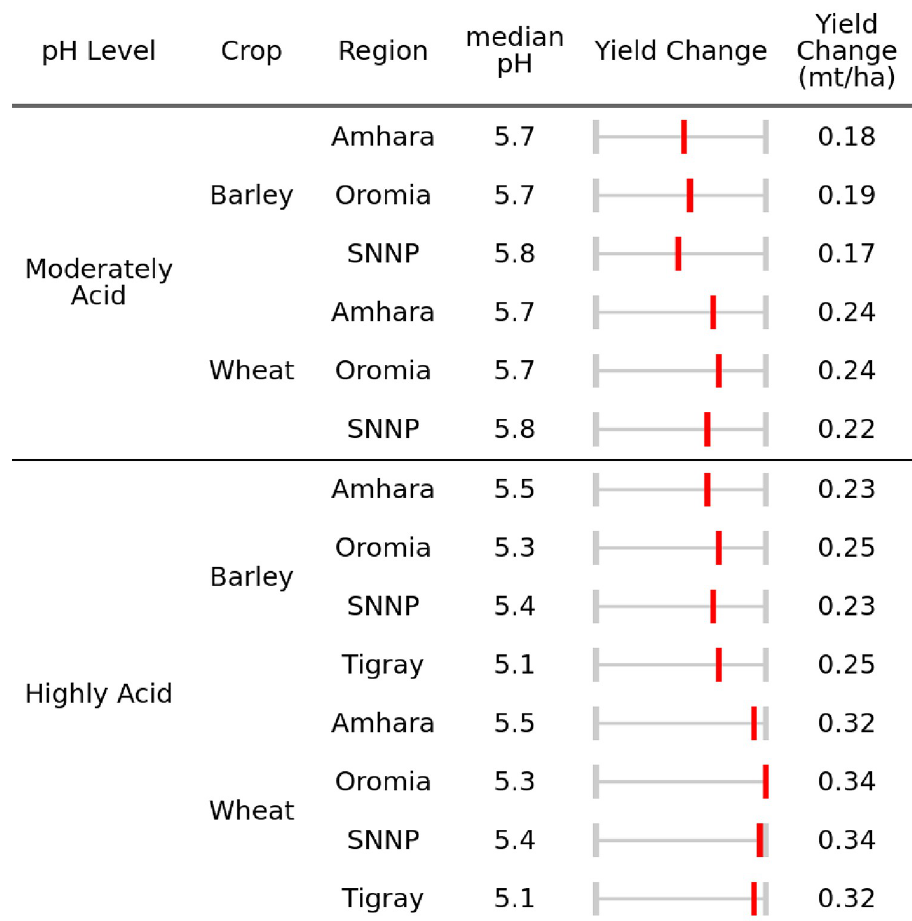
Fig 6. Median yield impact of increasing pH from actual to 6.5 for moderately and highly acidic soils.